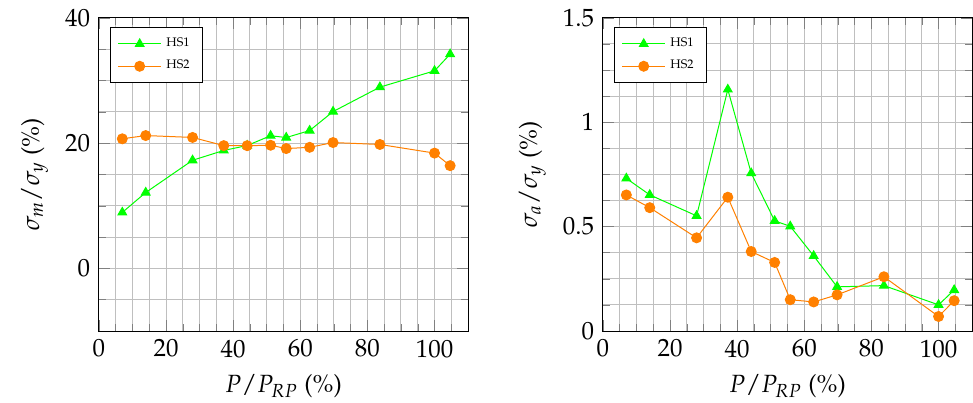
Figure 29. Static mean ( left ) and dynamic ( right ) stresses for HS1 and